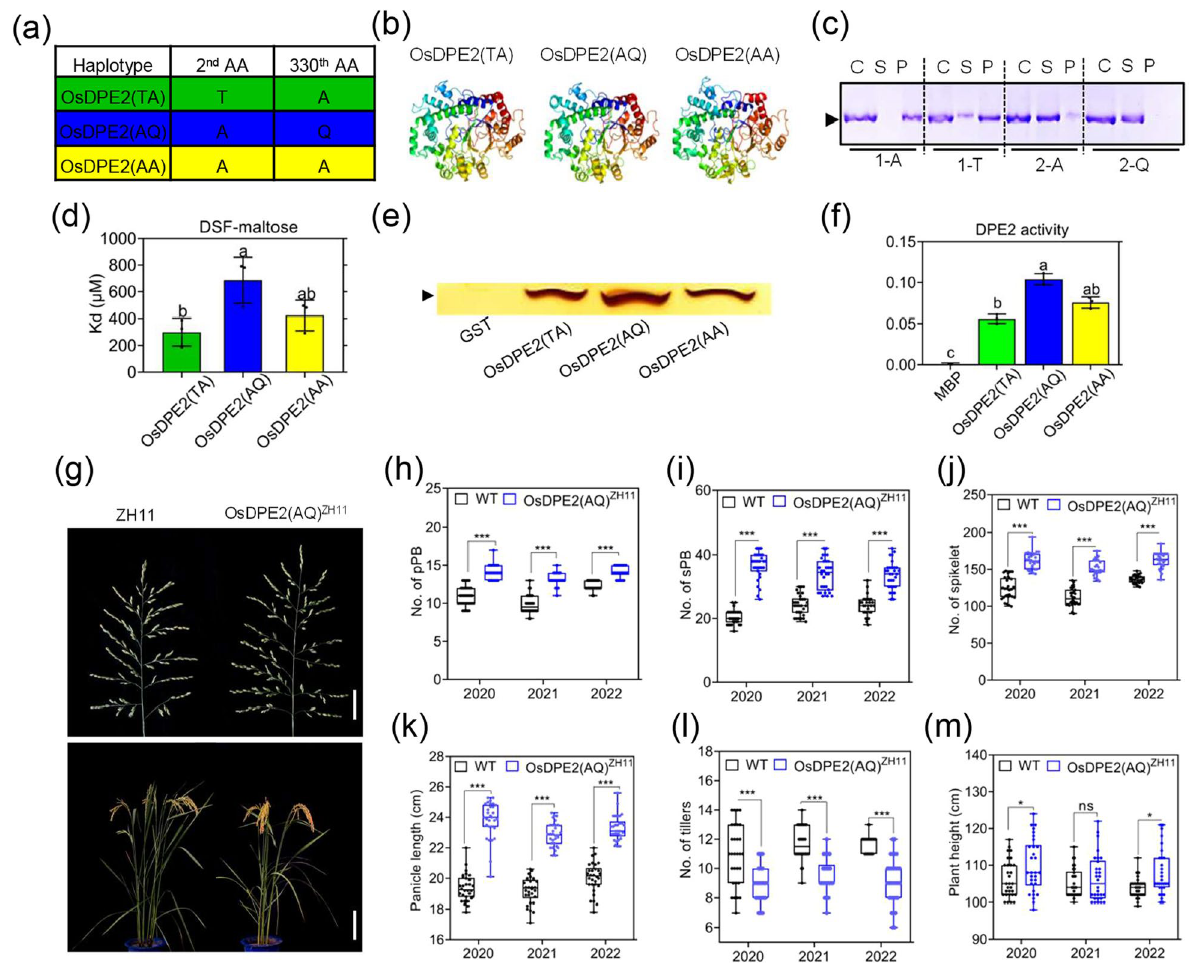
Fig. 6 Haplotype OsDPE2 with higher DPE2 enzyme increases the panicle yield of rice. a Haplotype analysis showing the 2nd and 330th amino acids of the OsDPE2 divided into three haplotypes: OsDPE2(TA), OsDPE2(AQ), and OsDPE2(AA). b Protein spatial structure of OsDPE2 haplotypes predicted by Phyre2. c Analysis of starch binding capacity of different haplotypes of OsDPE2 proteins and different CBM2 domain proteins with MBP tag. Starch binding capacity was determined as previously described (Ruzanski et al; 2013). Briefly, starch (20 mg) was incubated with label protein (20 μM) at 4 ℃ for 30 min. The reaction system was divided into precipitate (P) and supernatant (S) via centrifugation. The gel underwent vertical electrophoresis with 8% protein PAGE gel after denaturing the same amount of control group (C), supernatant (S) and precipitate (P). d The binding of recombinant proteins to the maltose assay of OsDPE2 haplotypes via differential scanning fluorimetry (DSF). Each data group had three replicates; Tukey’s multiple comparisons test. Different letters represent statistically significant differences between data groups. e In-gel DPE2 enzyme assay and f OD values of OsDPE2 haplotypes. Each data group had three replicates; Tukey’s multiple comparisons test. Different letters represent statistically significant differences between data groups. g Panicle and plant phenotypic characteristics of ZH11 and OsDPE2 (AQ) ZH11 . Scale bar of panicle 4 cm and plant 20 cm. h – m Yield traits of WT and OsDPE2(AQ) ZH11 for three consecutive years. Sidak’s multiple comparisons = = test. Bars represent mean SE (one-way ANOVA). n 30 biologically independent ± =